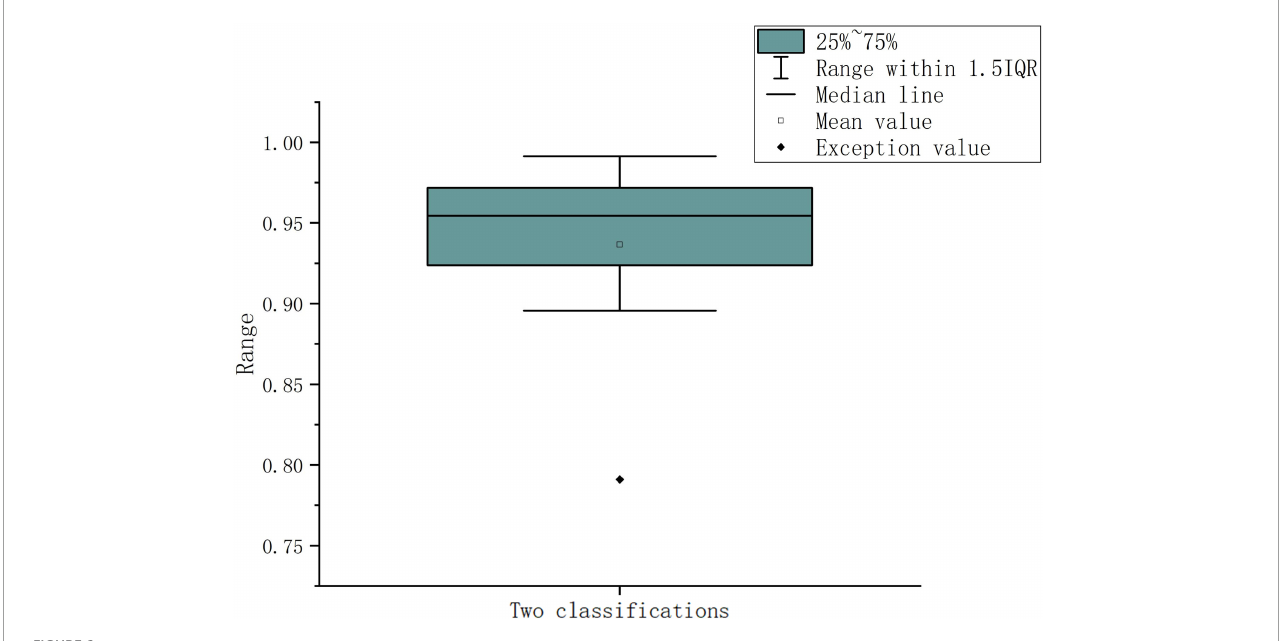
FIGURE6 Pairwise classification results for sub-period